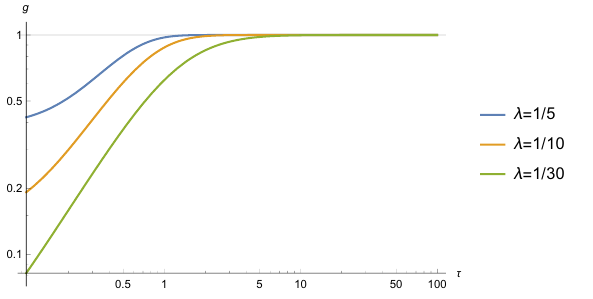
Figure 1 . Plot of the spectral form factor g ( (cid:12); t; ~ ) as a function of (cid:28) = ~ t for ~ = 1 = 30. Using our result in section 4, this is given by the error function